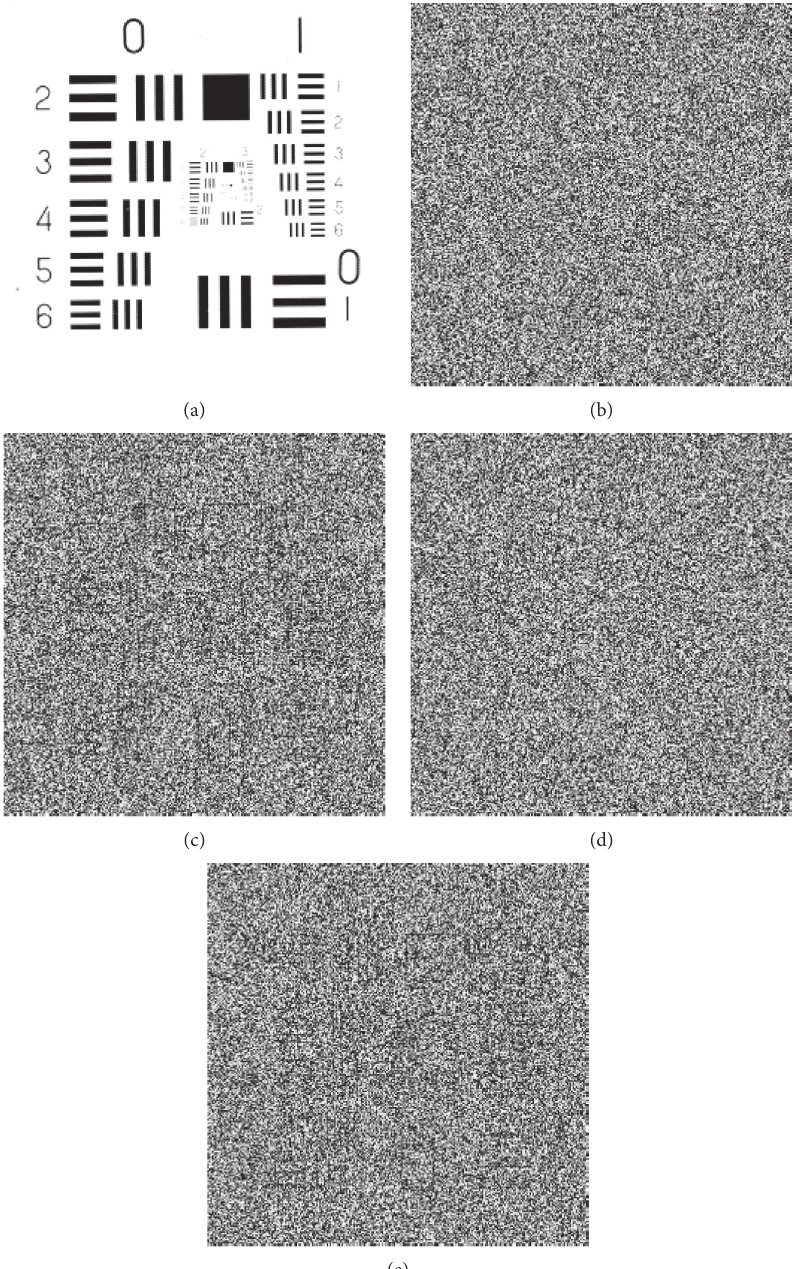
Figure 10: Decryption key sensitivity analysis: (a) the recovered image D ; (b, d) the recovered images D |( i � 1 , 2 ) . | D − D i